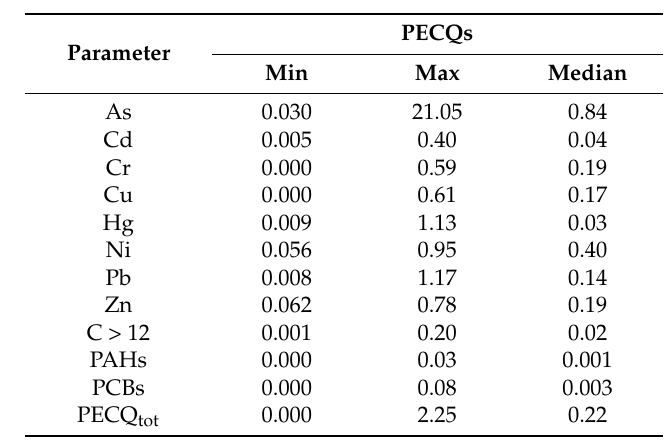
Table 3. Range (min, max) and median value of PECQ calculated for trace elements and organics analyzed in sediments of 20 Subalpine reservoirs. PECQ tot represents the mean value of all PECQs available for each